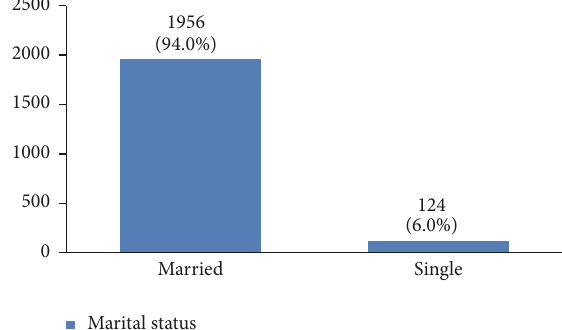
Figure 4: The marital status of the studied breast cancer